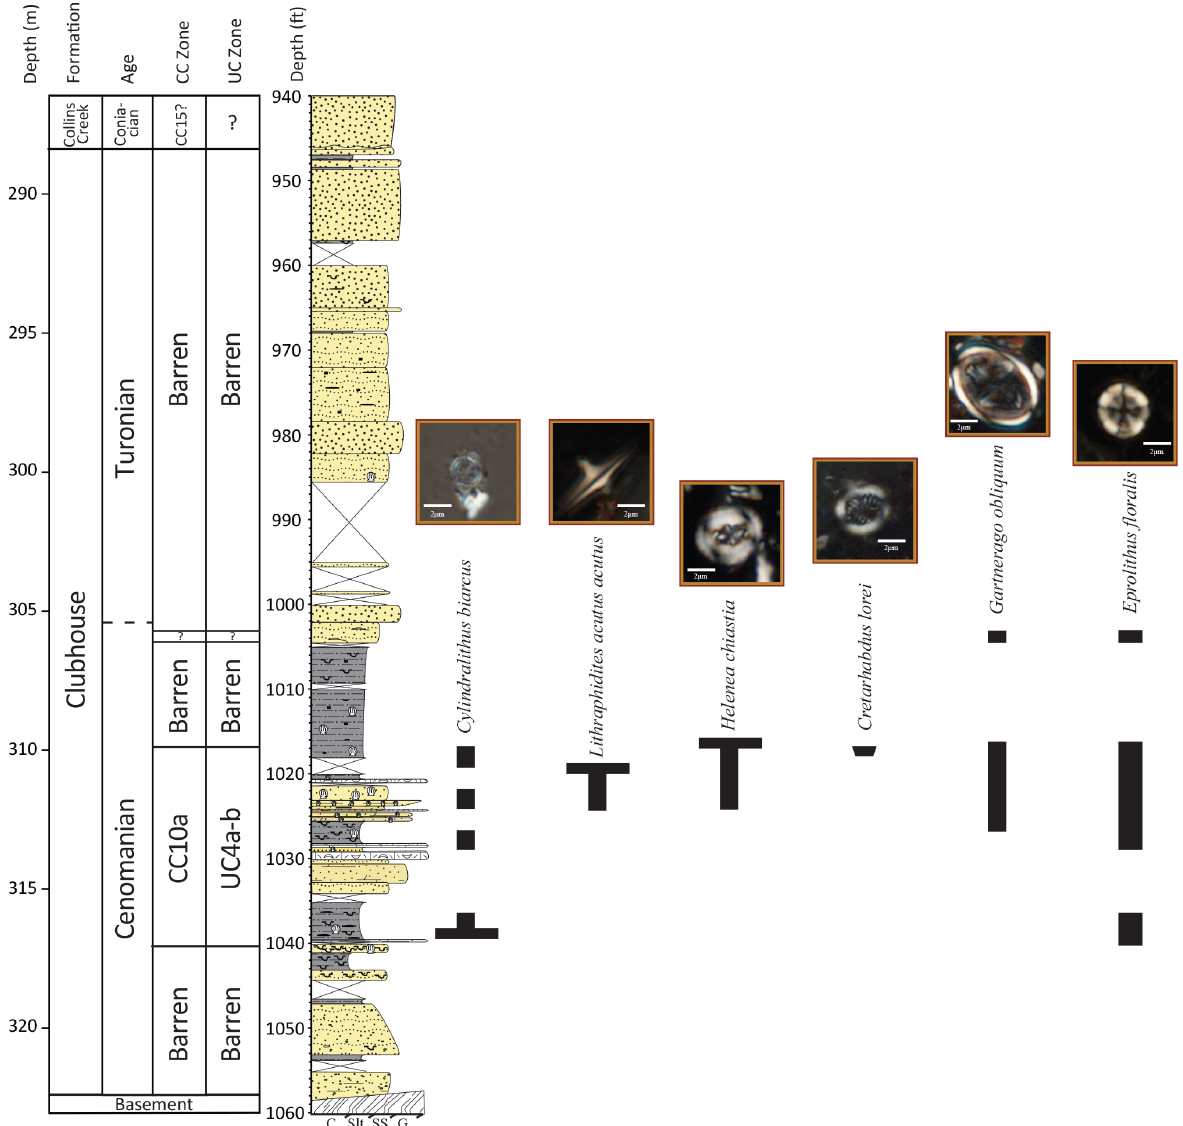
Figure 5. Ranges of key calcareous nannoplankton species in the Smith Elementary School core. Dashed lines indicate sporadic